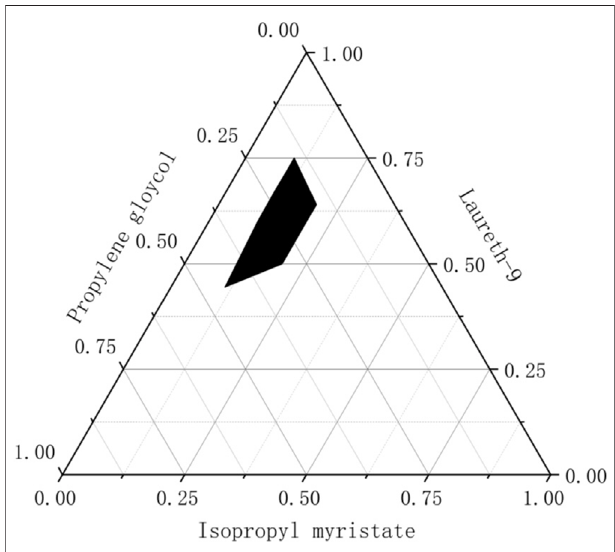
FIGURE 3 | The pseudo-ternary phase diagrams for W (oil).